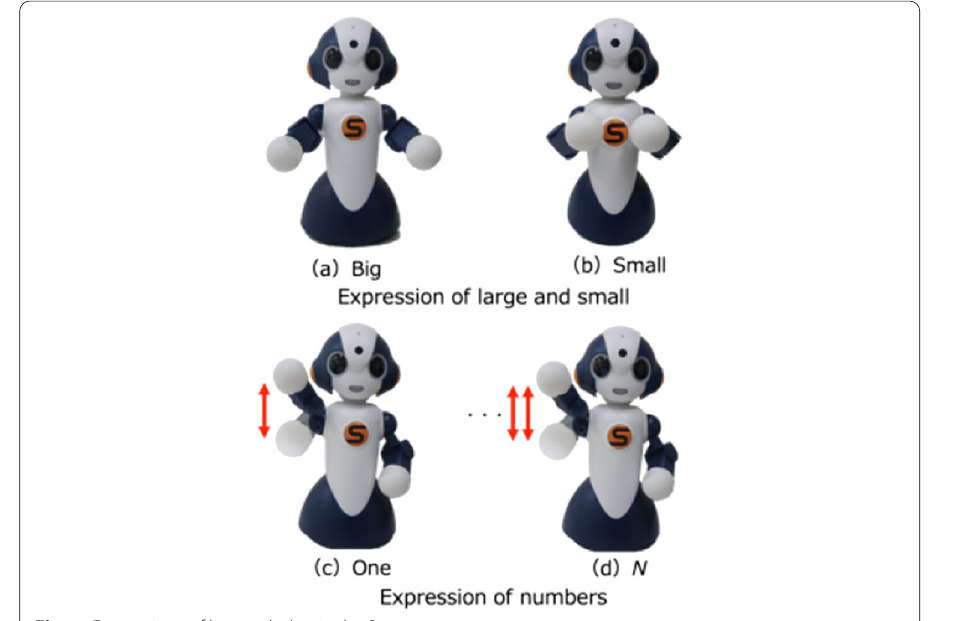
Fig. 7, for example, Sota represents big and small as iconic gesture by opening and clos- ing the arm in front of its